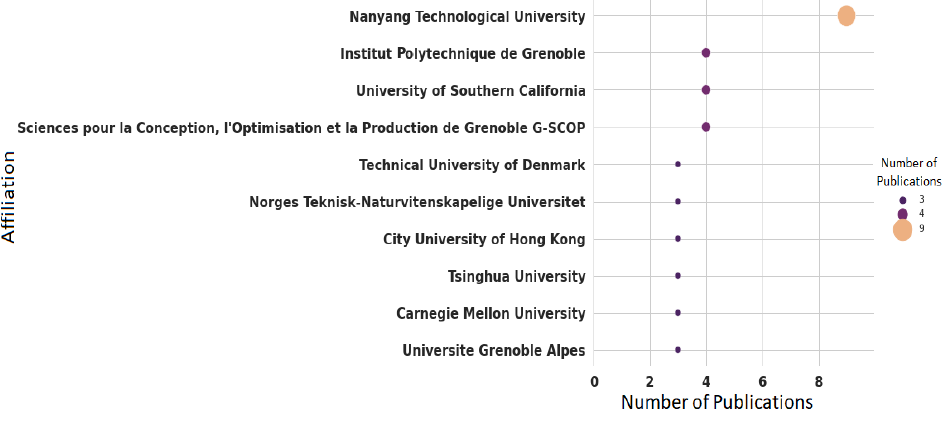
Figure 7. Publications on indoor occupancy estimation by